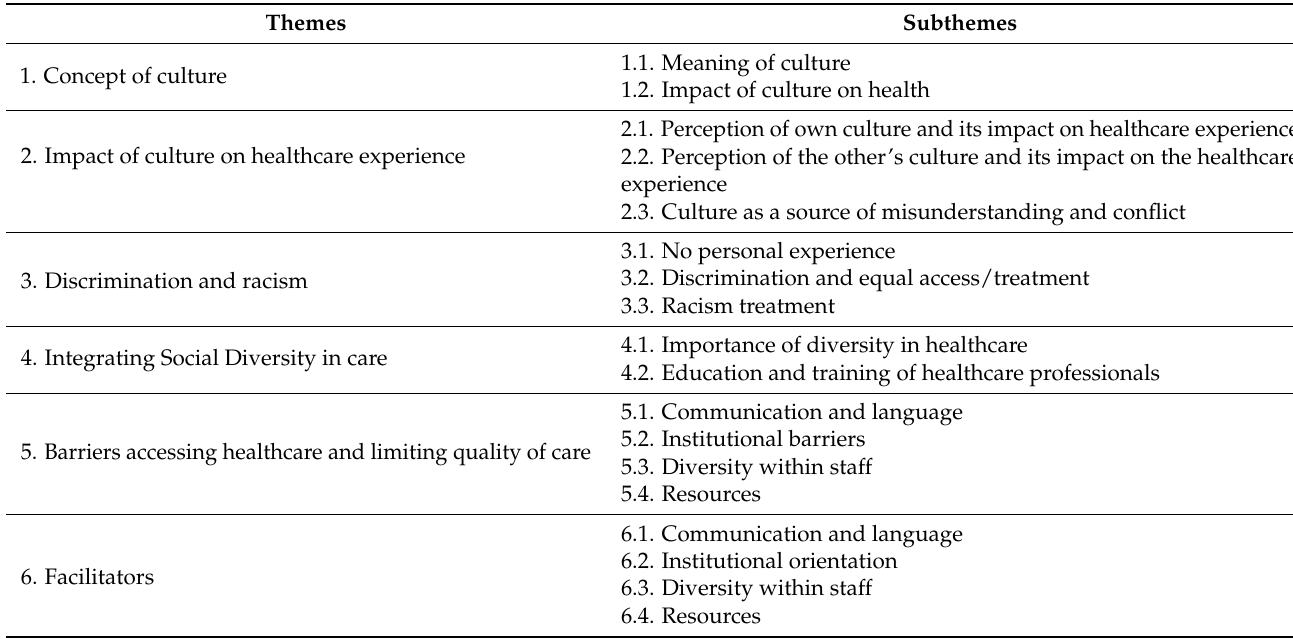
Table 2. Themes and